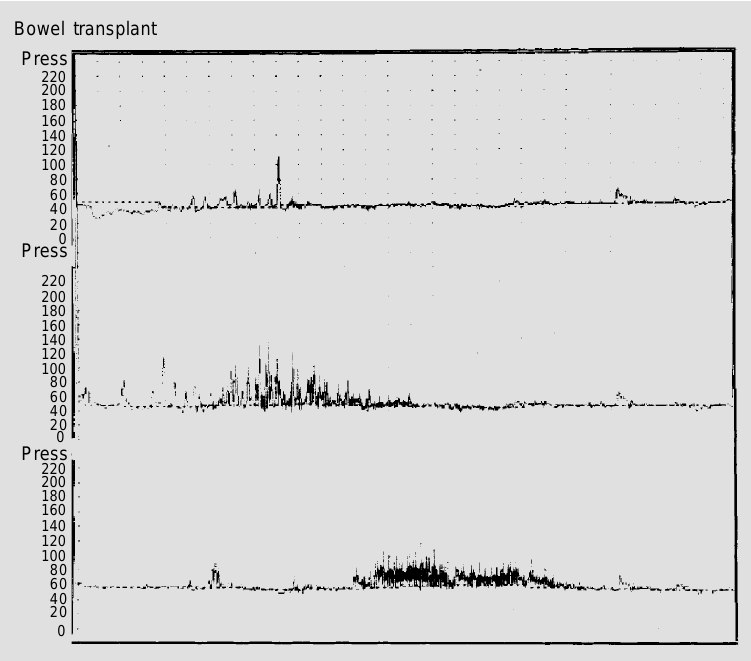
Figure 8 - Motor activity in the transplanted small intestine. Recording of intraluminal pressure activity three weeks following transplantation of the entire small intestine in a child. Note preservation of phase 3 activity in the transplanted